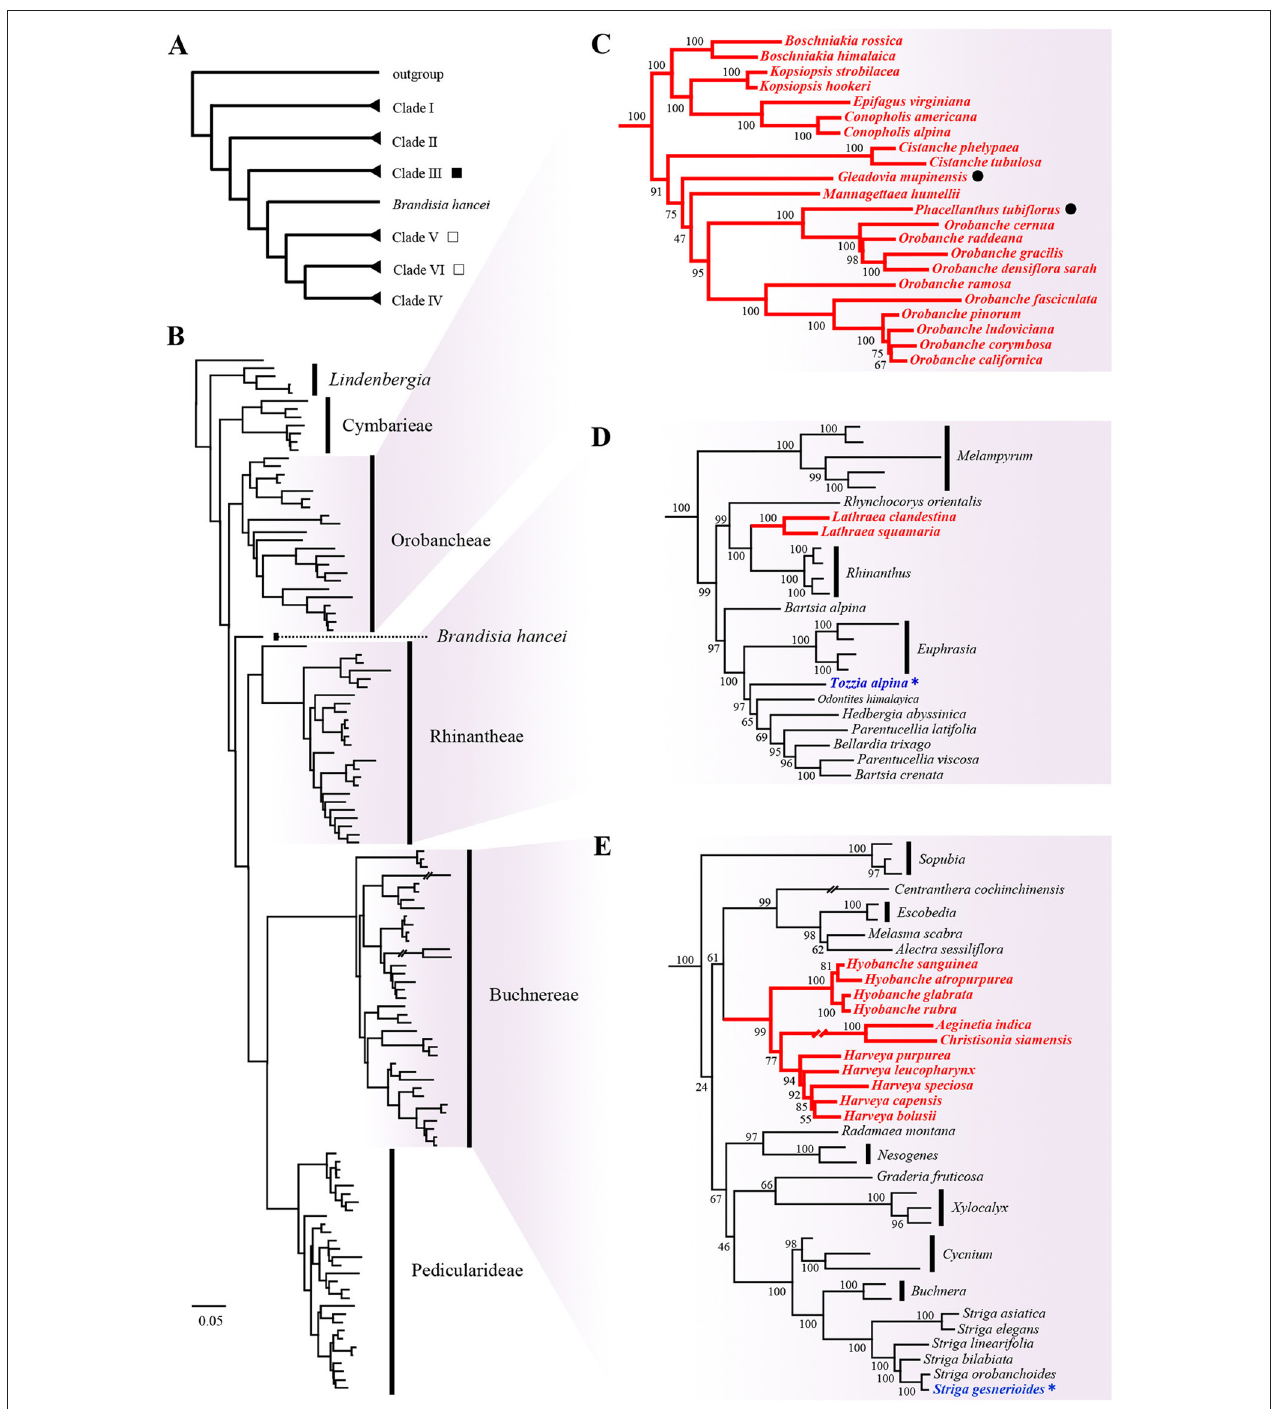
FIGURE 2 | Maximum likelihood phylogenetic trees of Orobanchaceae inferred from five combined genes. Simplified major backbone of Orobanchaceae shows the relationships among the main clades (A) and among corresponding taxa (B) . The name of each clade is indicated. (cid:3) means there are holoparasites in the clade, (cid:4) means this clade contains holoparasites only. Details including bootstrap values and GenBank accession numbers are presented in Figure S11 and Table S3 . Trees are rooted with Paulownia tomentosa . Three clades containing holoparasitic taxa are presented on the right: Clade III, Orobancheae (C) ; Clade V, Rhinantheae (D) ; Clade VI, Buchnereae (E) . Numbers above the branches indicate the maximum likelihood bootstrap values resulting from 1,000 replicates. Holoparasitic taxa are highlighted in red bold font. The taxa which were incorrectly placed in holoparasitic taxa in previous work are indicated in blue bold font and marked with an asterisk (*). The phylogenetic positions of Gleadovia and Phacellanthus are marked with • in Clade III, Orobancheae (C).